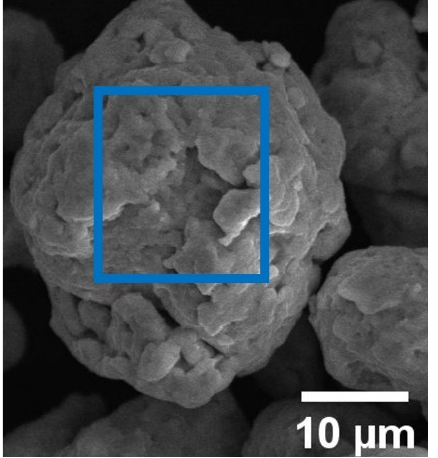
Figure 1. Example SEM image of a particle surface area for the SEM-EDS analysis. Vickers microhardness (HV 0.2 ) tests of the powders after different mechanical alloying times were performed using the PMT-3 tester (PMT Labs, Wah, Pakistan) under a load of 1.96 N (0.2 kg) for 15 s. For accurate results, at least ten indents were conducted on each sample and then the results were averaged and standard deviations